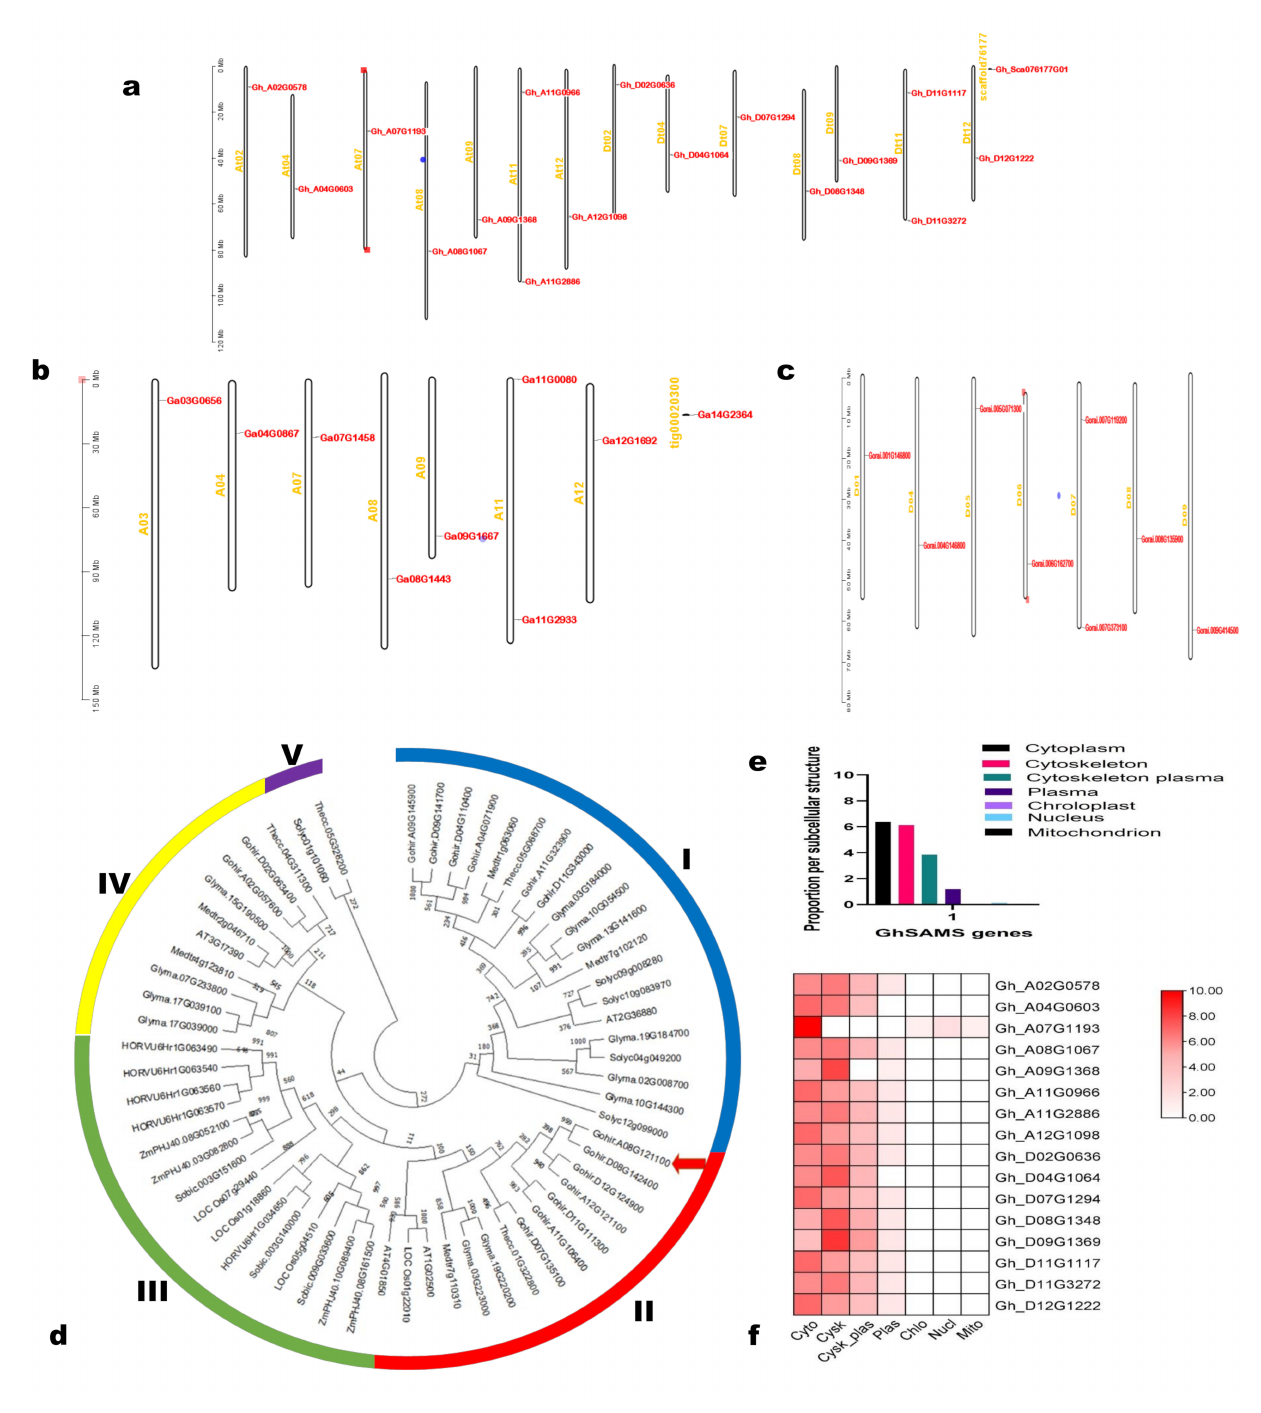
Figure 1. Chromosomal distribution, phylogenetic analysis, and subcellular localization of GhSAMS genes. ( a – c ) Distribution of GhSAMS genes on the chromosomes of G. hirsutum, G. arboreum , and G. raimondii , respectively. ( d ) Phylogenetic tree of GhSAMS genes and their homologs from A. thaliana , T. cacao , Soya bean, Rice, Tomato, Medicago truncatula , Sorghum, Maize, and Barley. ( e , f ) Subcellular localization of GhSAMS genes. The neighbor-joining method was used to construct the phylogenetic tree with replicates of 1000 bootstrap values in the MEGA 7.0